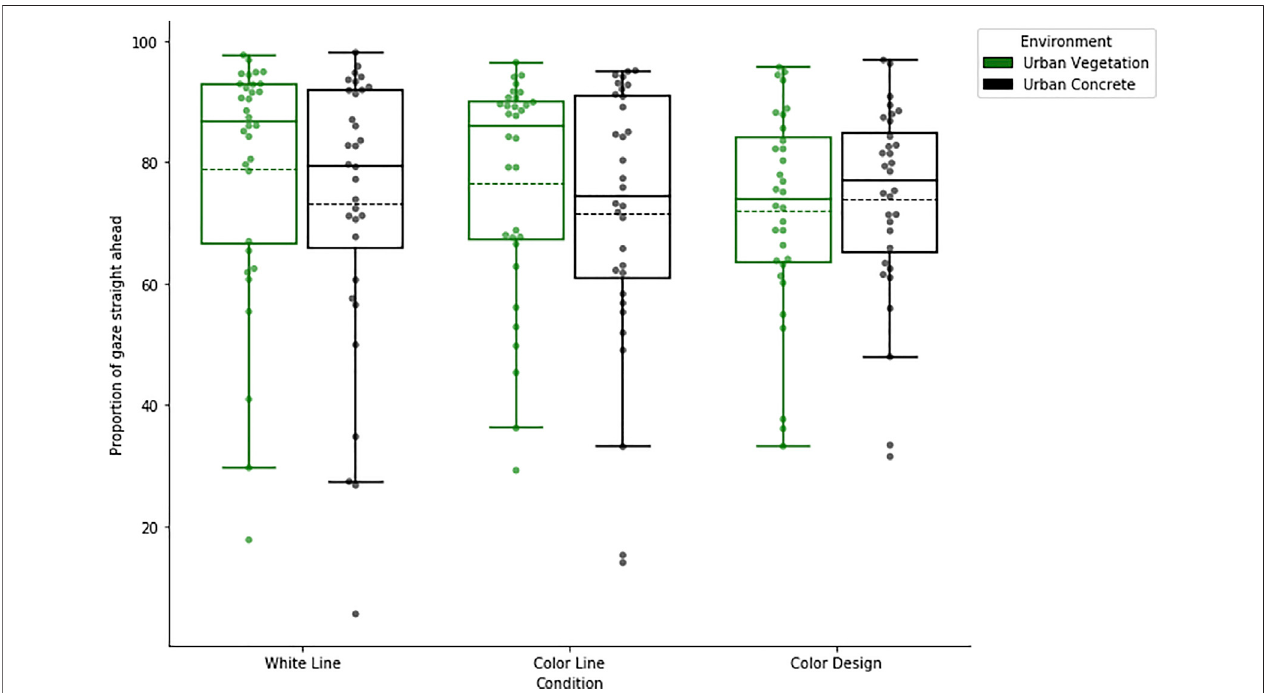
FIGURE 8 | Bar charts illustrating the impact of Environment (Concrete vs . Vegetation) on the proportion of time spent looking straight ahead during spontaneous walking in the six urban virtual environments.